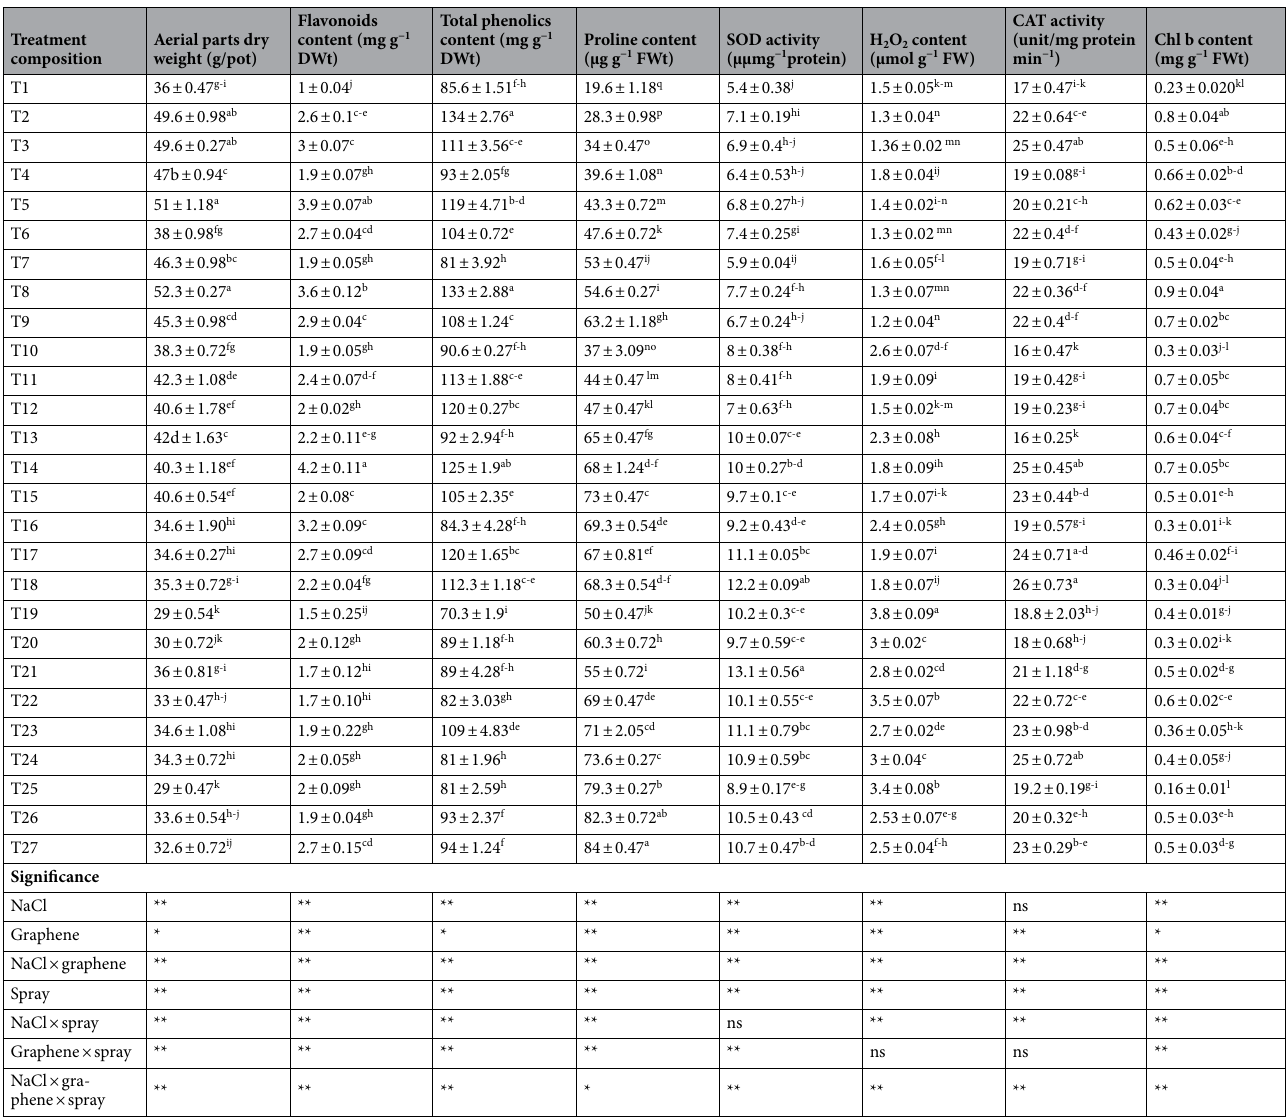
Table 1. Mean comparisons for the effect of soil-based graphene oxide and foliar application of selenium and nano-iron under salinity on the growth, physiological traits, and antioxidant enzymes activity of grape cv. sultana. Similar letters show no meaningful difference at 5% probability level by Duncan’s Multiple Range Test. Data are mean ± SD (n = 3 replicates). ns, ** and *: Non-significant, significant at 1 and 5 percentage probability levels, respectively. T1: NaCl 0 × graphene 0 × Spray 0 ; T10: NaCl 50 × graphene 0 × Spray 0 ; T19: NaCl 100 × graphene 0 × Spray 0 . T2: NaCl 0 × graphene 0 × Spray Fe ; T11: NaCl 50 × graphene 0 × Spray Fe ; T20: NaCl 100 × graphene 0 × Spray Fe . T3: NaCl 0 × graphene 0 × Spray Se ; T12: NaCl 50 × graphene 0 × Spray Se ; T21: NaCl 100 × graphene 0 × Spray Se . T4: NaCl 0 × graphene 50 × Spray 0 ; T13: NaCl 50 × graphene 50 × Spray 0 ; T22: NaCl 100 × graphene 50 × Spray 0 . T5: NaCl 0 × graphene 50 × Spray Fe ; T14: NaCl 50 × graphene 50 × Spray Fe ; T23: NaCl 100 × graphene 50 × Spray Fe . T6: NaCl 0 × graphene 50 × Spray Se ; T15: NaCl 50 × graphene 50 × Spray Se ; T24: NaCl 100 × graphene 50 × Spray Se . T7: NaCl 0 × graphene 100 × Spray 0 ; T16: NaCl 50 × graphene 100 × Spray 0 ; T25: NaCl 100 × graphene 100 × Spray 0 . T8: NaCl 0 × graphene 100 × Spray Fe ; T17: NaCl 50 × graphene 100 × Spray Fe ; T26: NaCl 100 × graphene 100 × Spray Fe . T9: NaCl 0 × graphene 100 × Spray Se ; T18: NaCl 50 × graphene 100 × Spray Se ; T27: NaCl 100 × graphene 100 × Spray Se